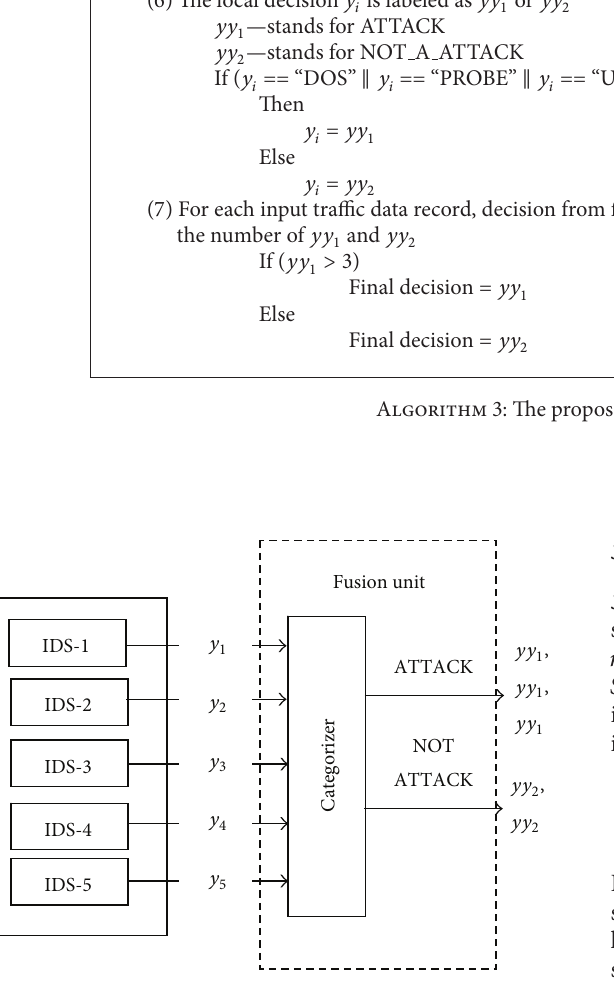
Figure 2: Fusion